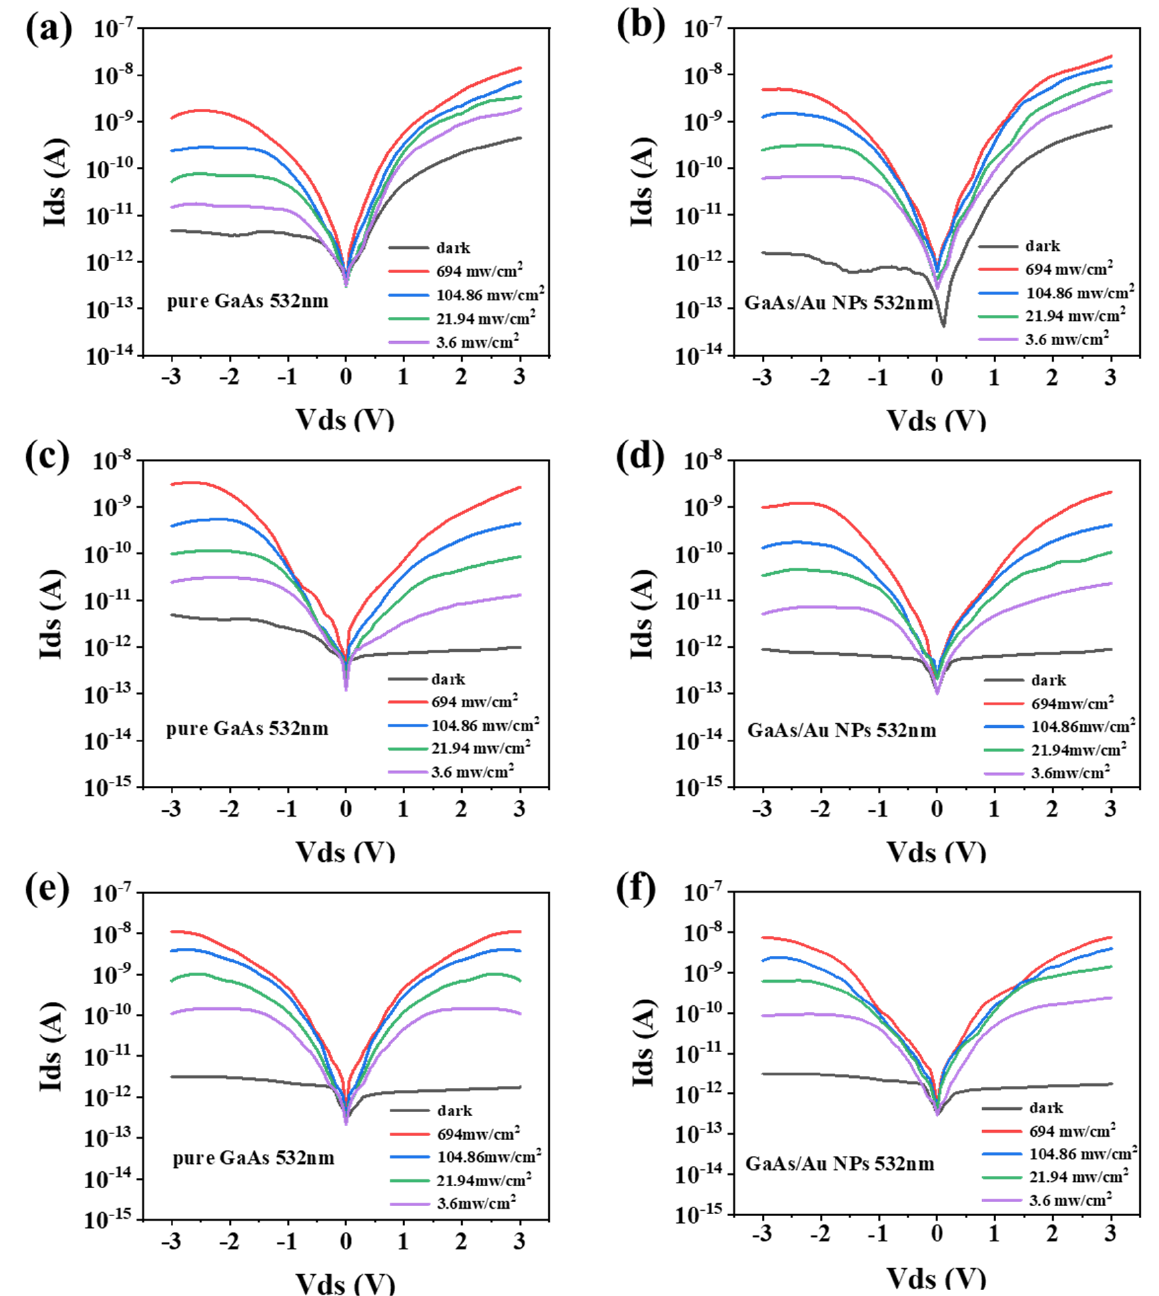
Figure 4. I-V characteristic curves of the GaAs nanowire photodetectors before and after modification. ( a , c , e ) I-V characteristic curve of the original photodetectors. ( b , d , f ) I-V characteristic curve of the photodetectors after the modification time is 10 s, 30 s and 50 s, respectively.